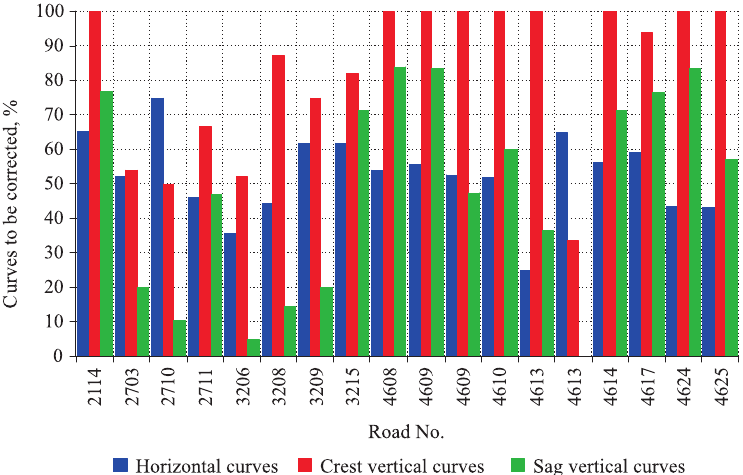
Fig. 2. Distribution of horizontal and vertical curves to be corrected when V